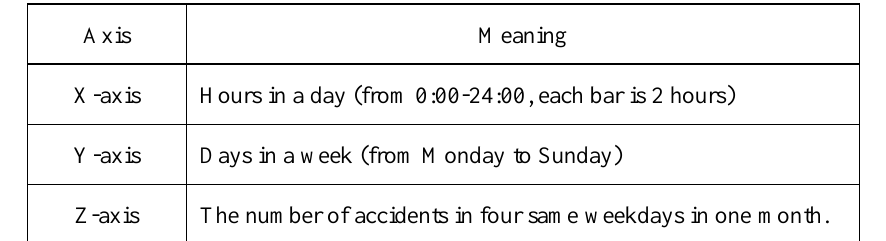
Table 7. The explanation of information in different